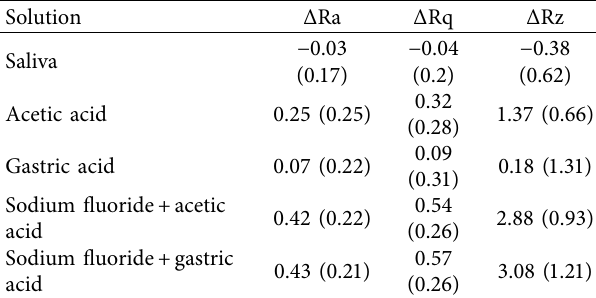
Table 1: Mean and standard deviation of changes of Ra, Rq, and Rz parameters of Vitablocs Mark II CAD before and after immersion in different